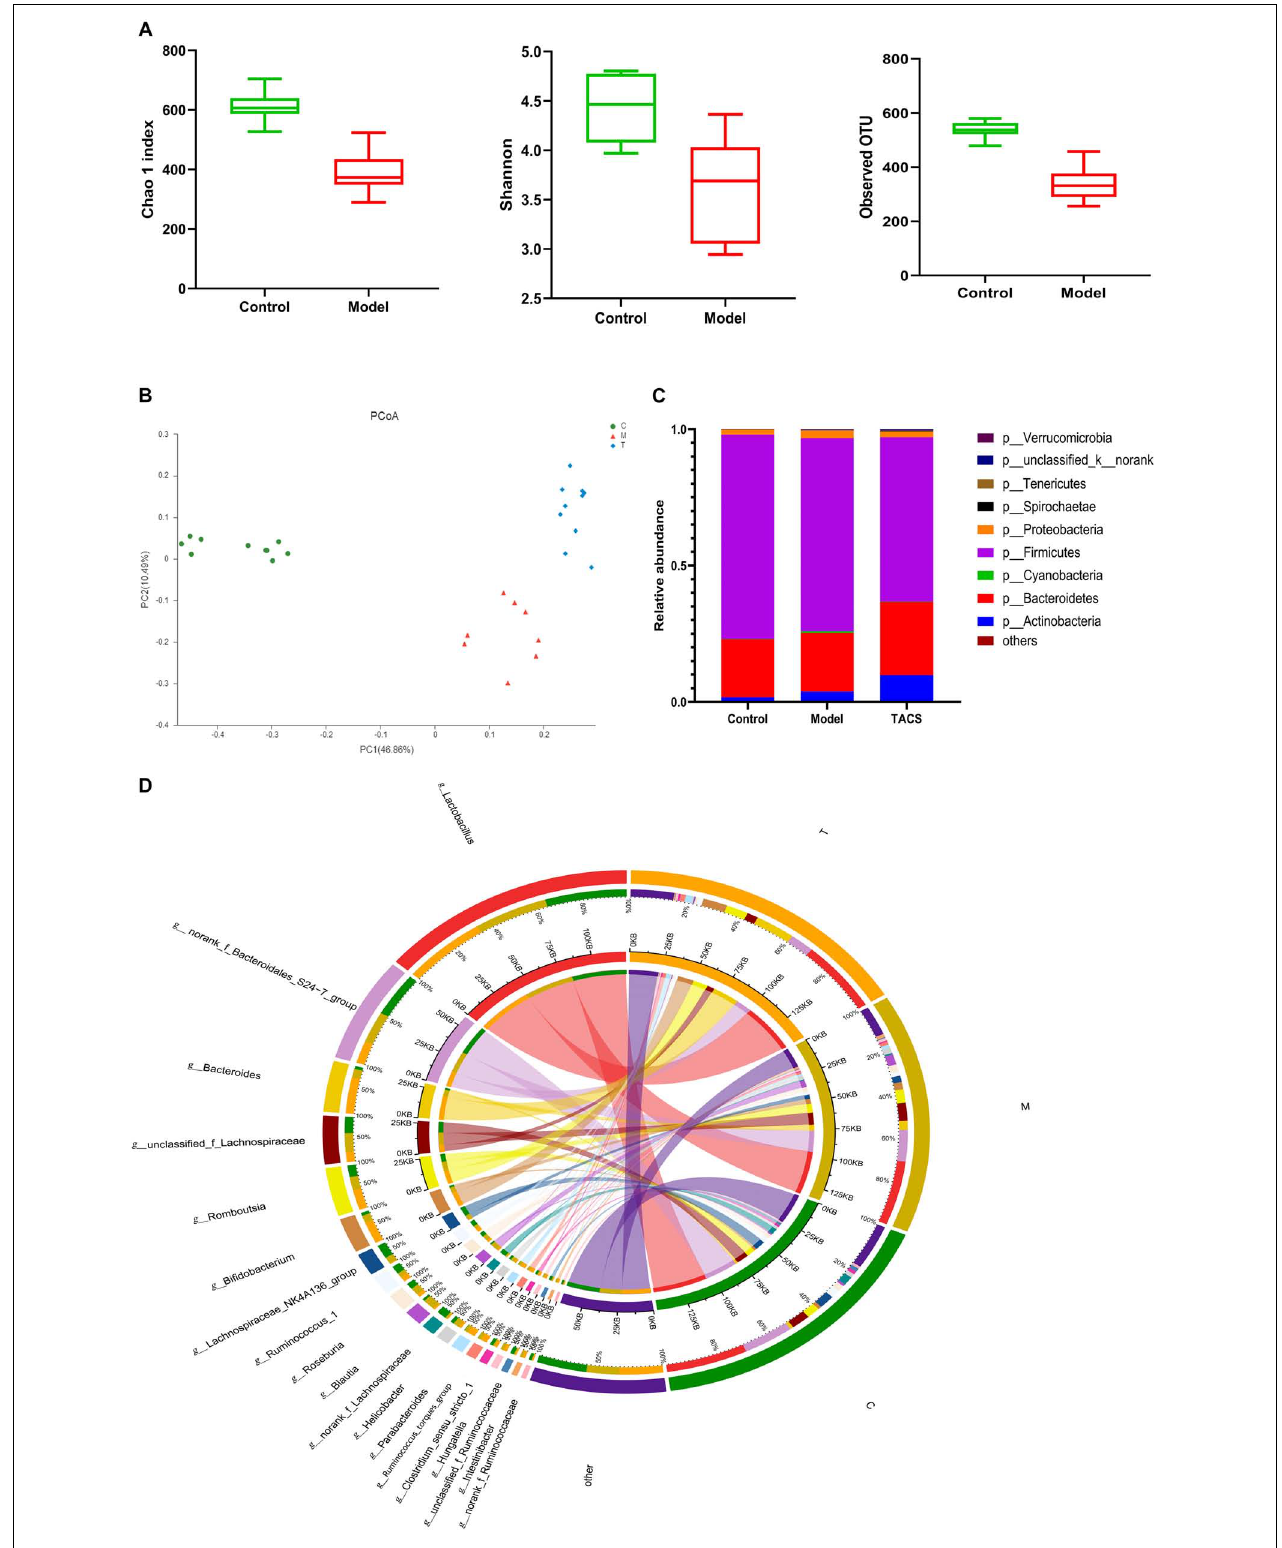
FIGURE 1 | Gut microbial diversity and richness in the control and antibiotic-only groups (A) . Principal coordinate analysis (PCoA) (B) and bacterial phylum composition profiles (C) of gut microbiota community in the control group (C), antibiotic-only group (M), and TACS group (T). Circos plot (D) connecting genera detected by 16S rRNA gene sequencing with the gut microbiota profiles in the control group (C) and antibiotic-only group (M).